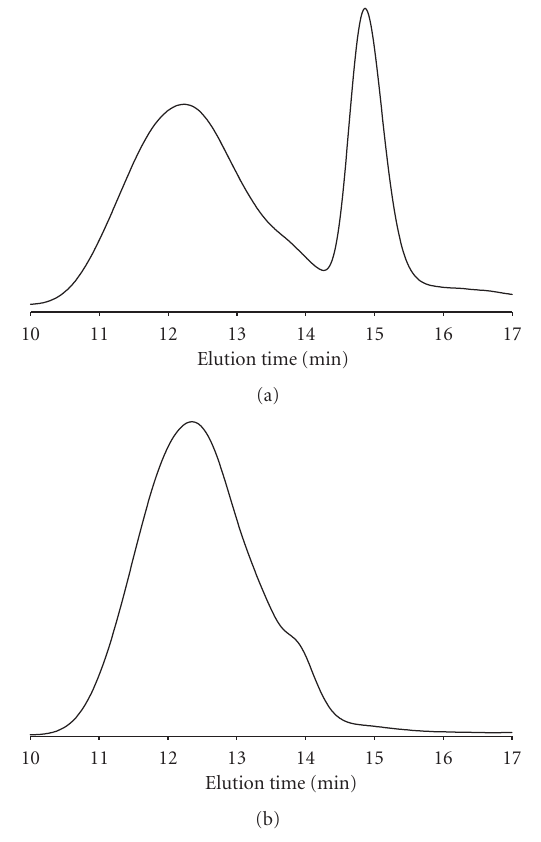
Figure 3: SEC chromatograms of copolymer 9 (a) prior to and (b) following purification by preparative